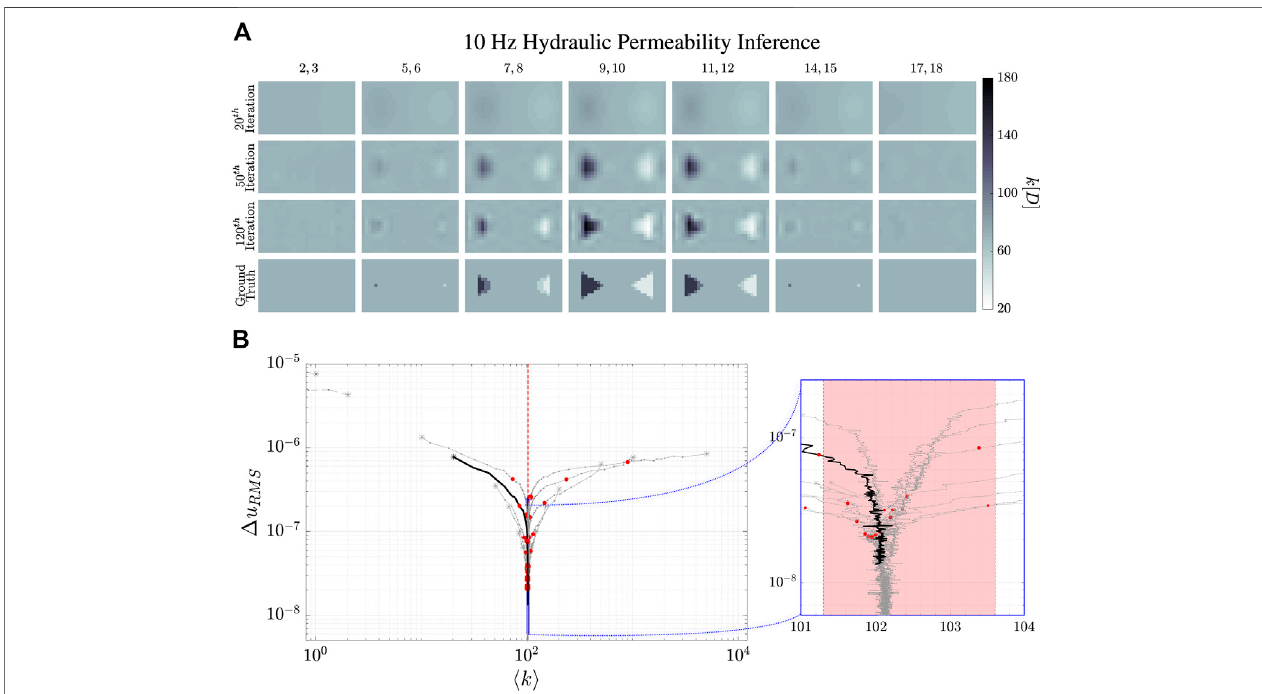
FIGURE 6 | Reconstruction evolution of the hydraulic permeability, k , at 10 Hz. (A) shows the reconstructed images of the hydraulic permeability distribution. The column images are the averages of the numbered ( xy ) -planes (top row). The rows are labeled by the iteration number of the inference. (B) shows the lower dimensional trajectory of the shear modulus. As above, the hydraulic permeability is measured in Darcy. The smaller diagram is a magni fi ed region near the converged values. Initial estimates are noted by an asterisk and changes in descent strategy are indicated by small and large red markers, as explained in the text. The light red region represents the strip between the background value of the shear modulus and the ground truth mean value. The thicker trajectory is the one used to make the images in the above panel. One cansee that the convergence ofthe permeability occurs well before the fi nal change in descent strategy. Itappearsthat proper inference is robust to initial conditions 2 orders of magnitude greater than the ground truth, while only 1 order of magnitude